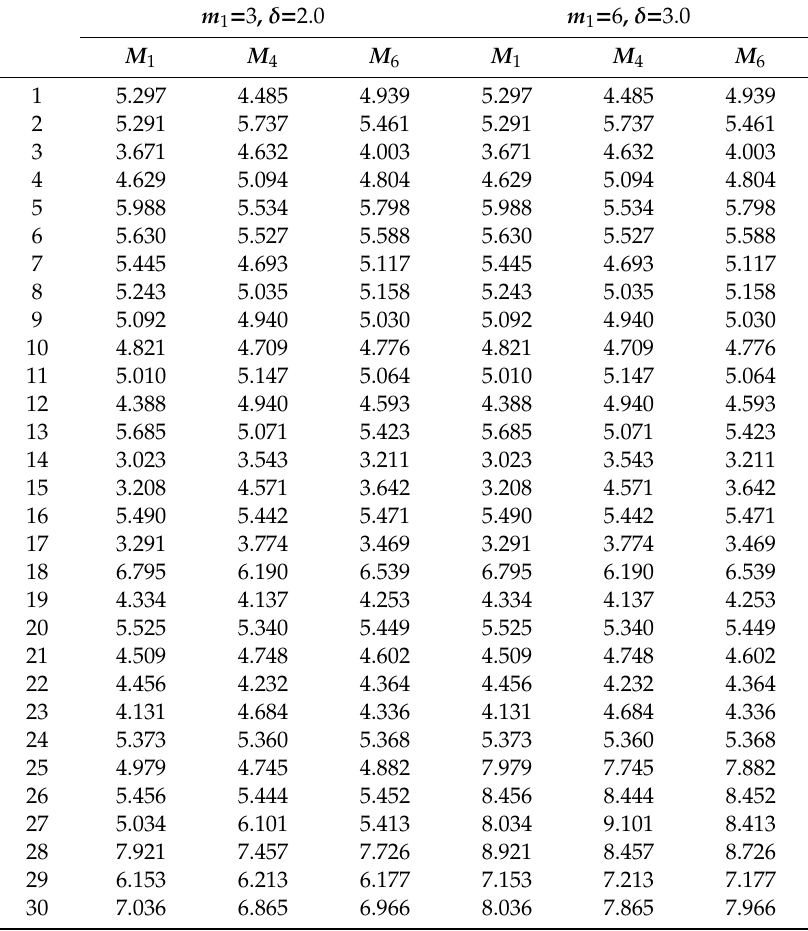
Table 6. Control limits of the median charts based on M 1 , M 4 and M 6 for the non-iso-thermal continuous stirred tank chemical reactor (CSTR) data. M 1 M 4 M 6 LCL UCL LCL UCL LCL UCL m 1 = 3, δ = 2.0 m 1 = 6, δ = 3.0 Table 7. Plotting statistics of the median charts based on M 1 , M 4 and M 6 for CSTR Data. m 1 = 3 , δ = 2.0 m 1 = 6 , δ =